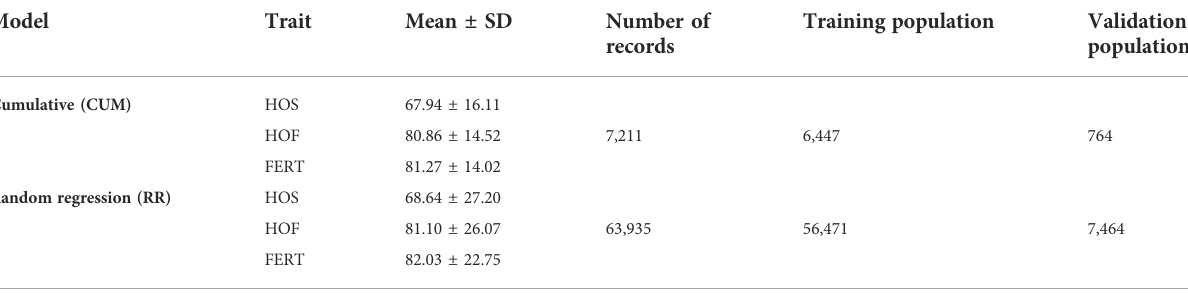
TABLE 1 Descriptive statistics of the evaluated traits hatch of set (HOS), hatch of fertile (HOF), and fertility of set (FERT) including the number of records for each model, mean, standard deviation, and the number of records in the training and validation populations for each model. Model Trait